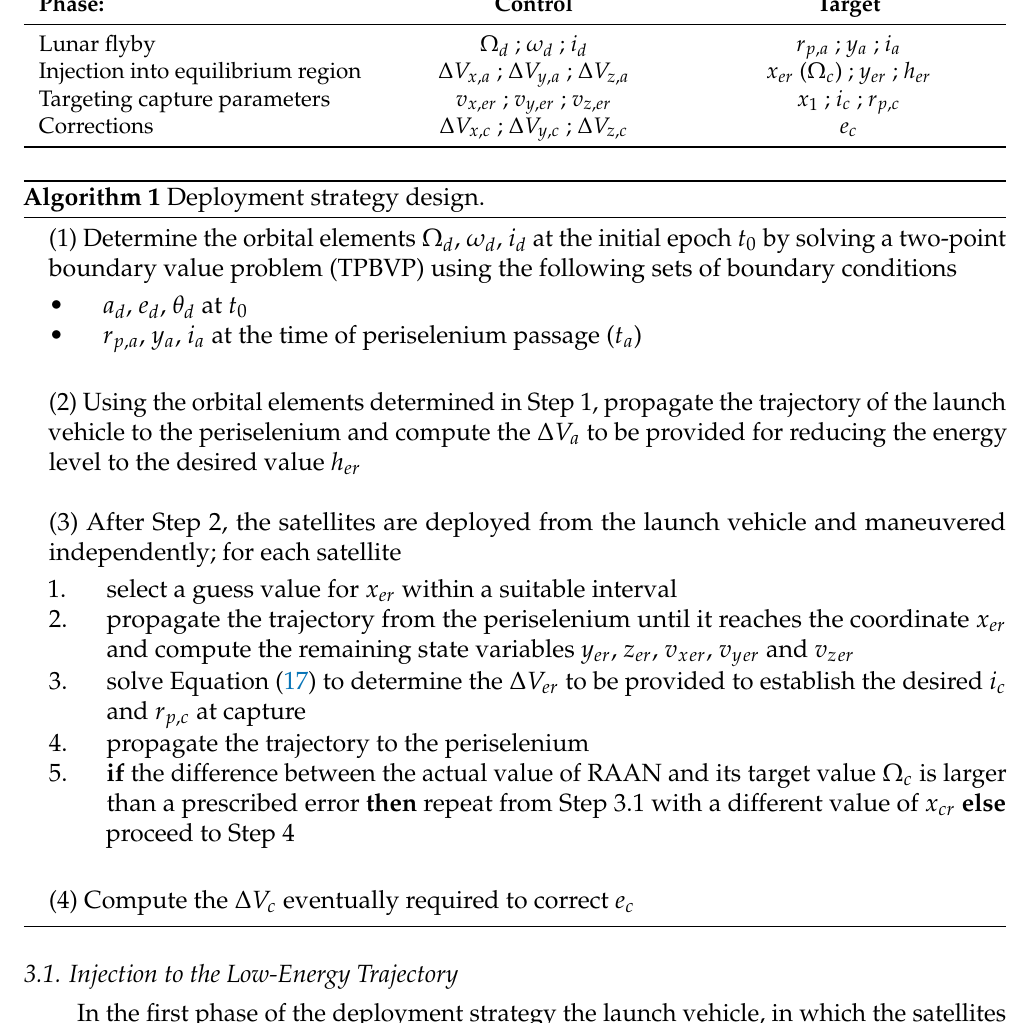
Table 2. Summary of control and target parameters during the different phases of the deployment.